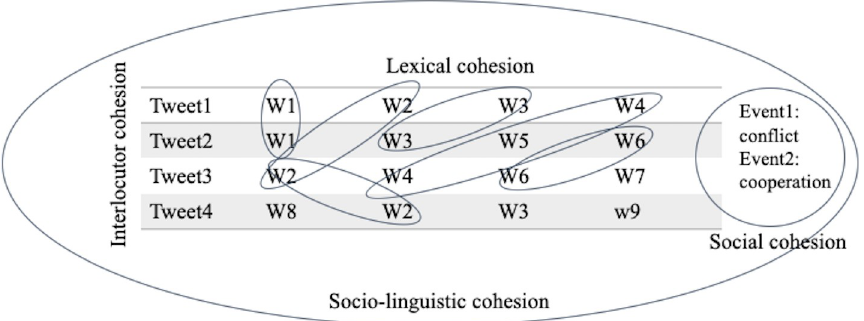
Fig 1. A visual representation of cohesion in tweets. The shared content words–either identical or semantically similar–constitute a theme around which cohesion is